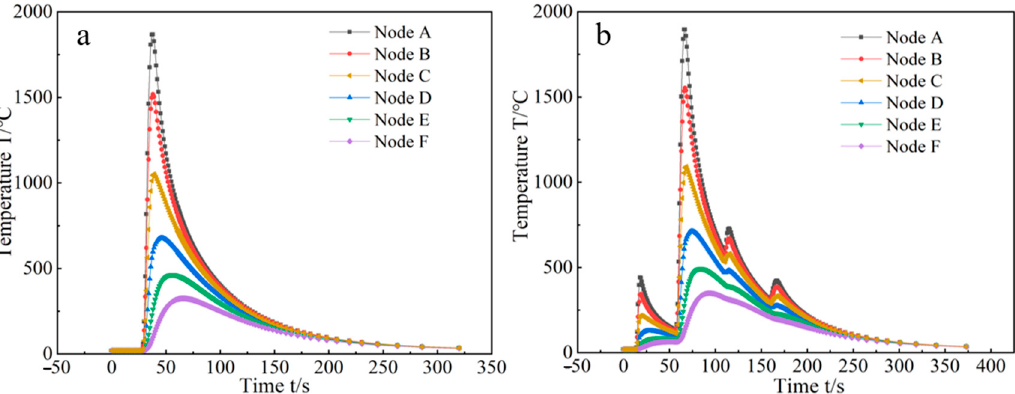
Figure 10. Temperature changes with time at points A, B, C, D, E and F. ( a ) one time welding, ( b ) pre-heating, welding, and post- heating.